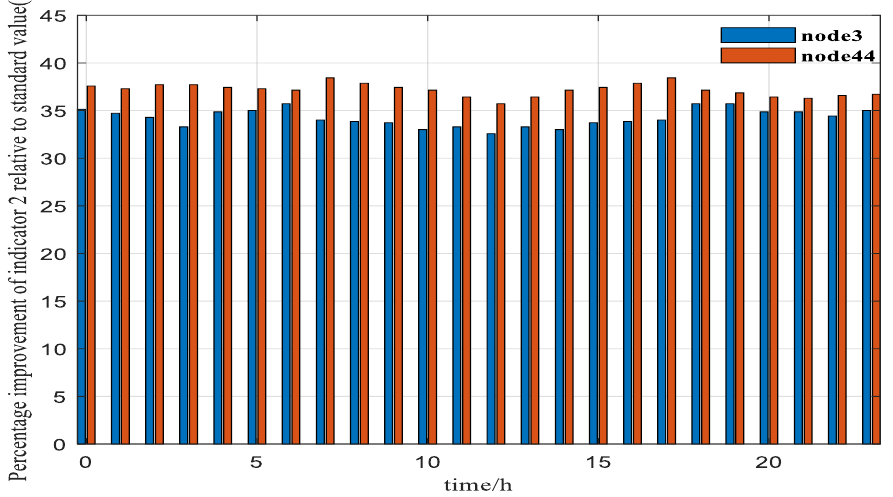
Figure 14. Percentage improvement of voltage deviation relative to the standard value.